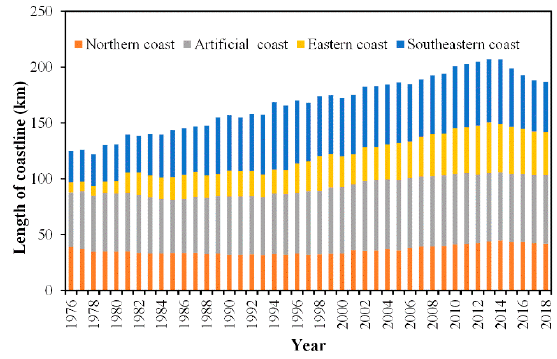
Figure 4. Changes in the coastline length of the Yellow River Delta from 1976 to 2018.